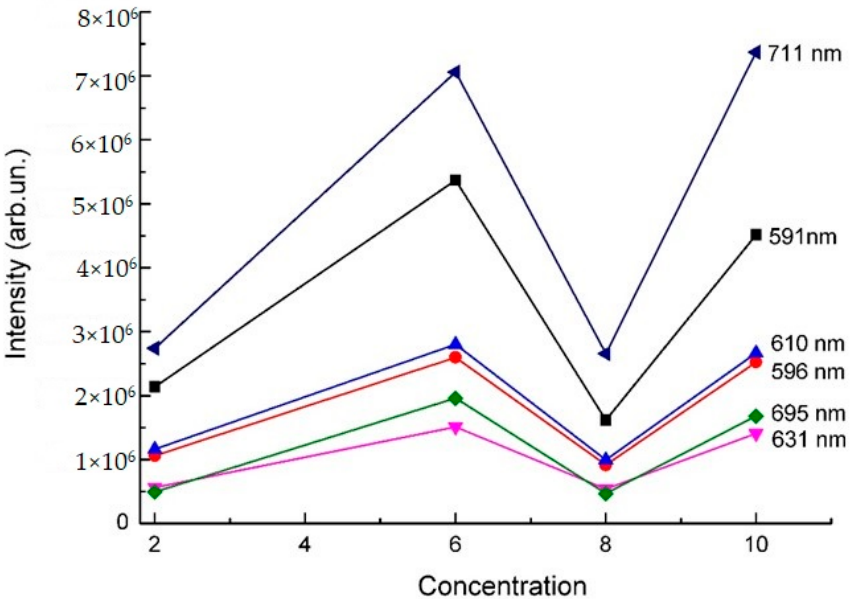
Figure 14. Intensity dependency of the photoluminescence spectrum on the wavelength for three samples. Triangle, circle, square are used for designation of the values of intensities of different bands at different concentrations.